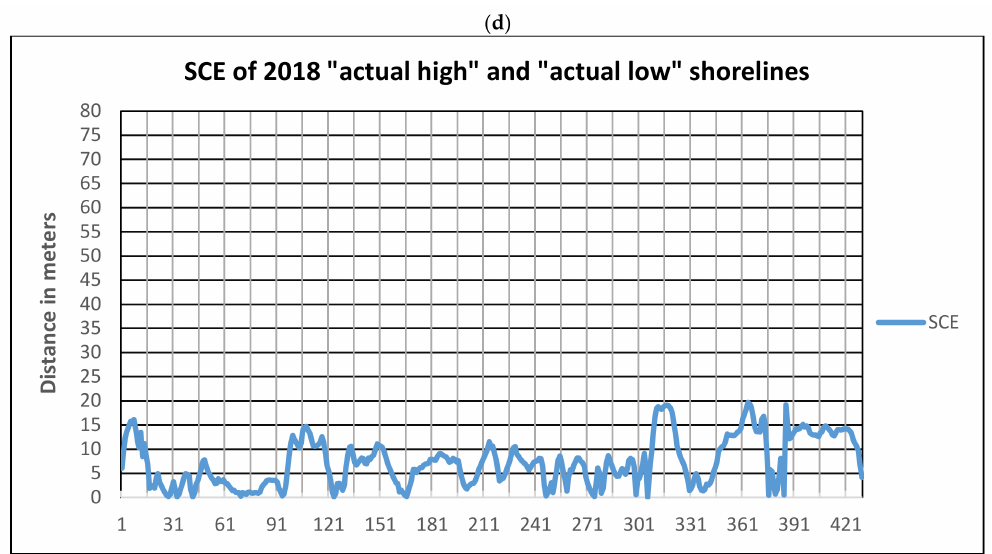
Figure 10. SCE statistical rates from low- and high-resolution vectorized shorelines in 2018 for Karnari beach.